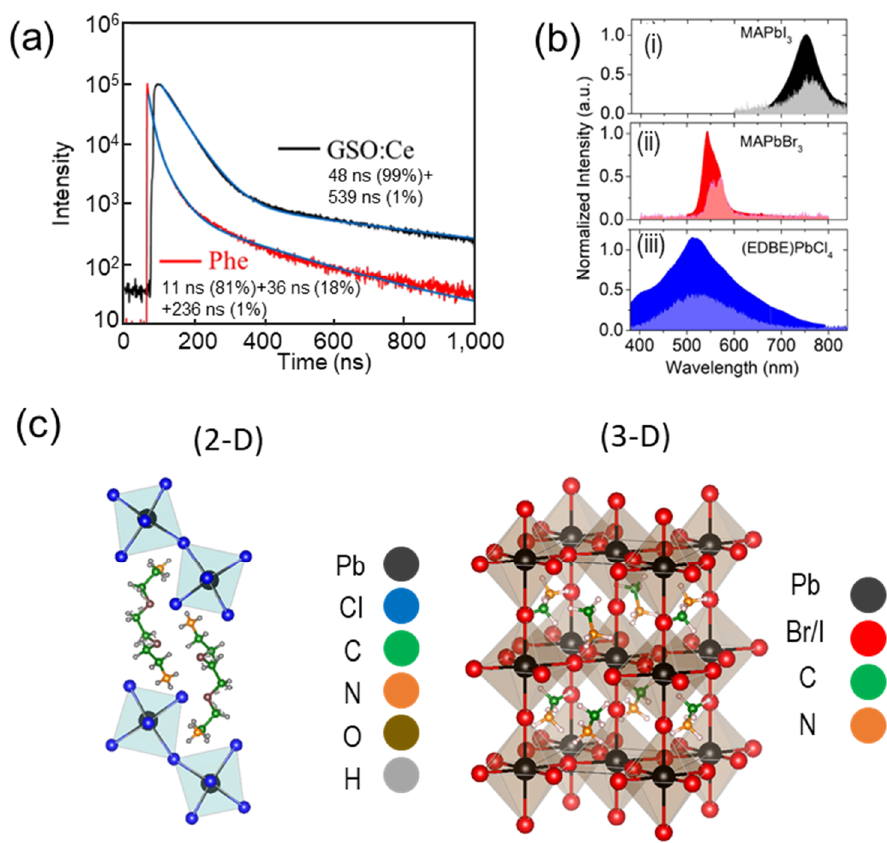
Figure 11. ( a ) Scintillation decay time profile of Phe and gadolinium orthosilicate (GSO): Ce under X-ray irradiation. Reproduced from Reference [171] with open access; ( b ) X-ray excited luminescence (light color area) and photoluminescence (dark color area) spectra of (i) MAPbI 3 , (ii) MAPbBr 3 , and (iii) (EDBE)PbCl 4 recorded at RT. Reproduced from Reference [57] with open access.; ( c ) Crystal structure representation of MAPbX 3 (X = I, Br) 3D perovskites ( right ), and (EDBE)PbCl 4 2D perovskite ( left ).